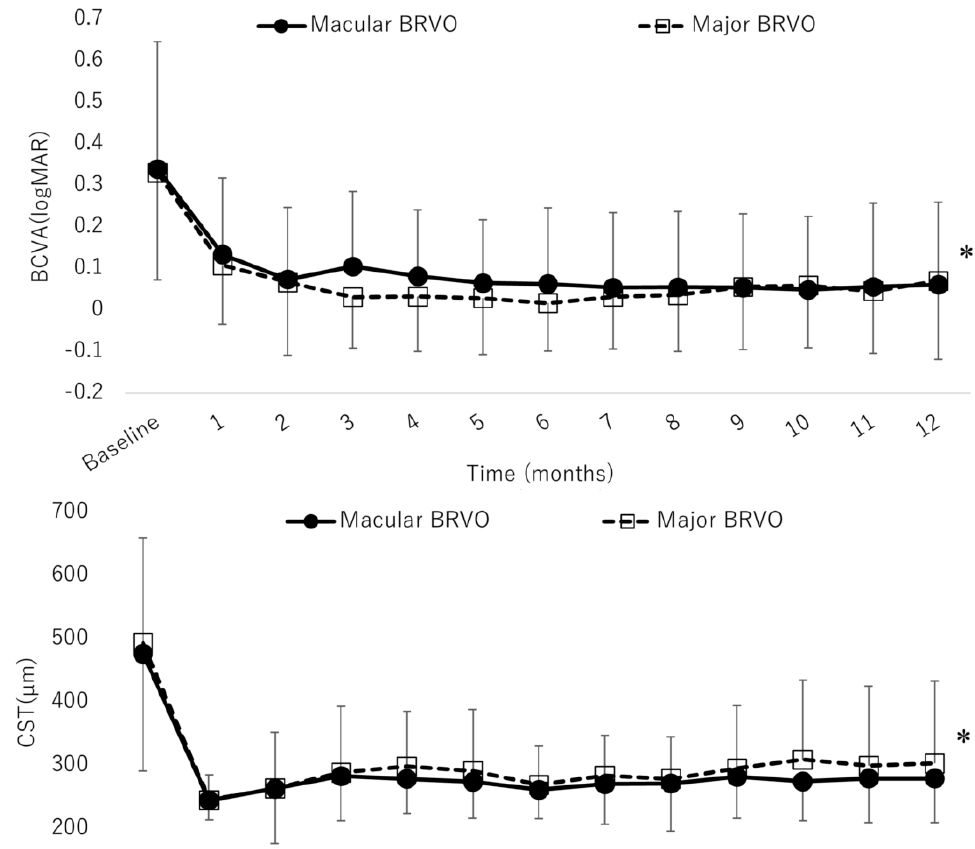
Figure 5. Mean BCVA (logMAR) and CST of major branch retinal vein occlusion (BRVO) and macular BRVO over time to month 12. *: p < 0.0001.